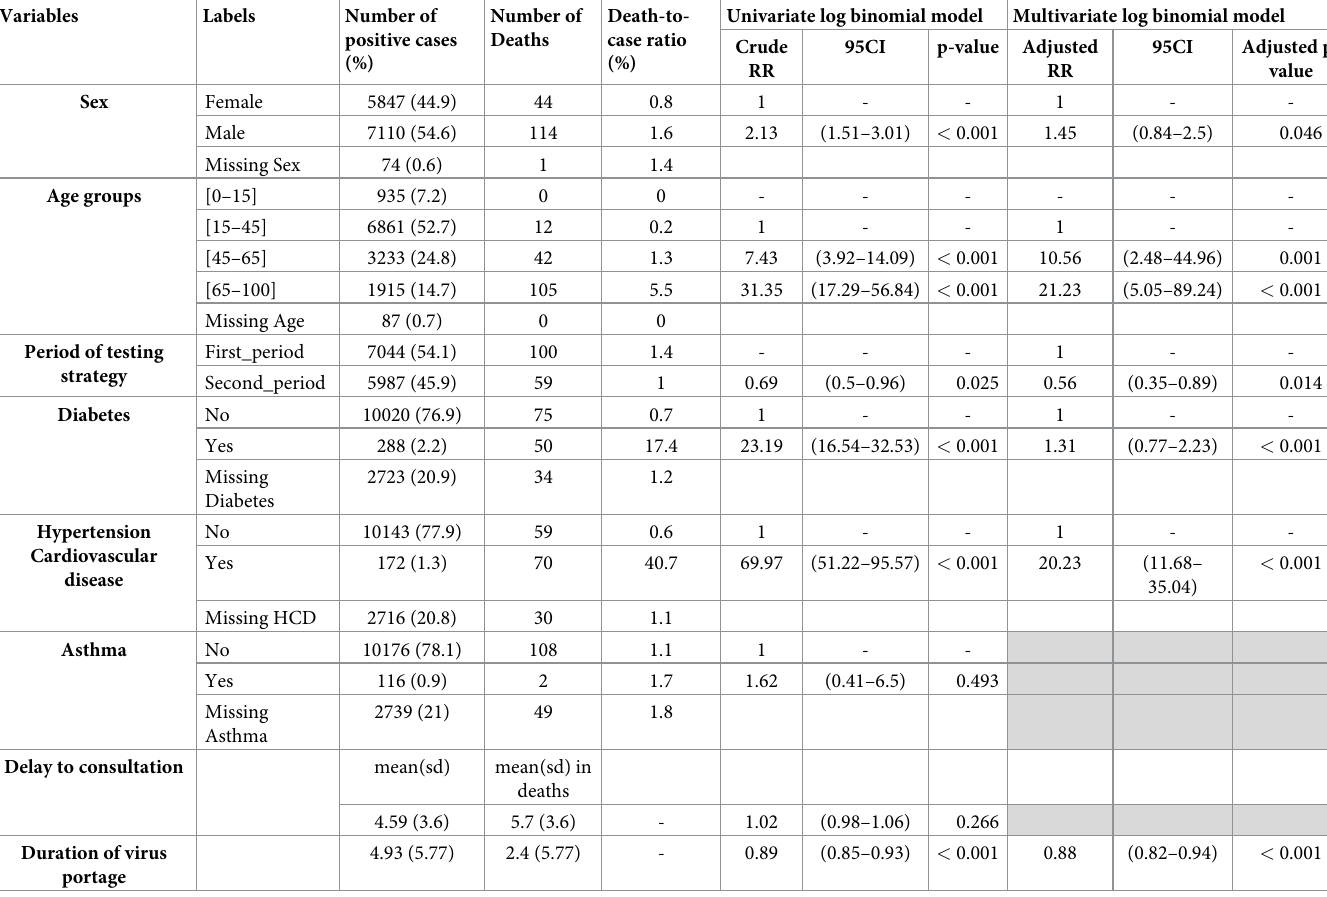
Table 3. Univariate and multivariable factors analysis according to "survival/dead"